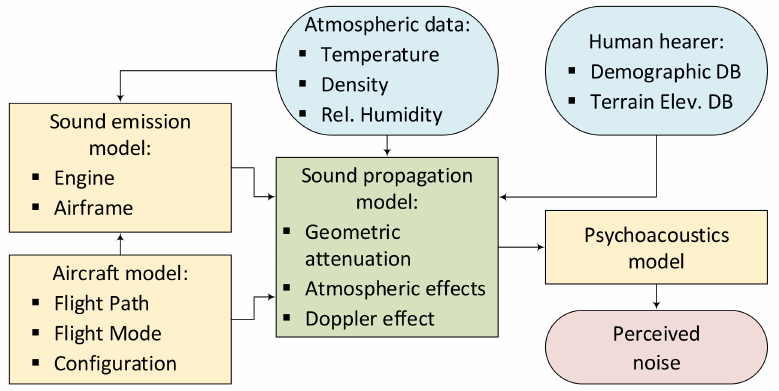
Figure 2. Noise modelling flow